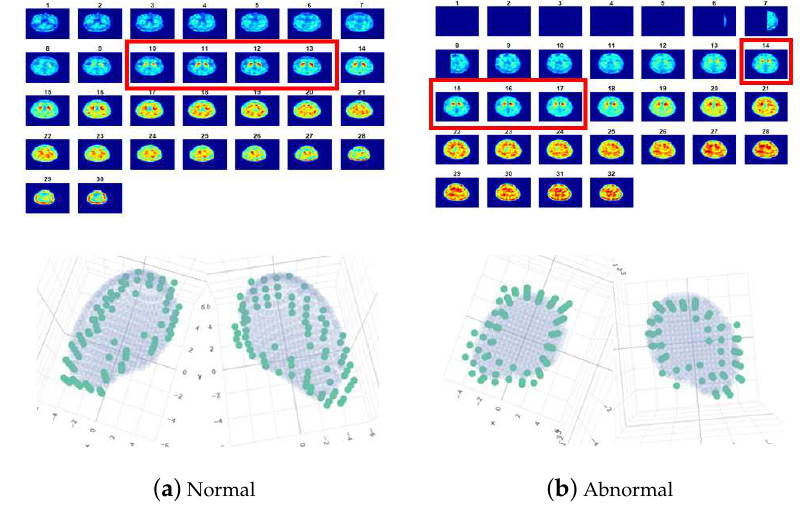
Figure 7. The sequences of 2D images (in the upper panel) and the corresponding cashew-shaped surfaces (in the lower panel) of ( a ) a normal subject and ( b ) an abnormal subject in 3D space. In the upper panel, the four 2D images in the red rectangles are suggested by the physicians and are used to construct the cashew-shaped surfaces. In the lower panel, the green points denote the boundary points collected from the four 2D images for left/right striatum in 3D space, and the gray areas are the corresponding fitted cashew-shaped